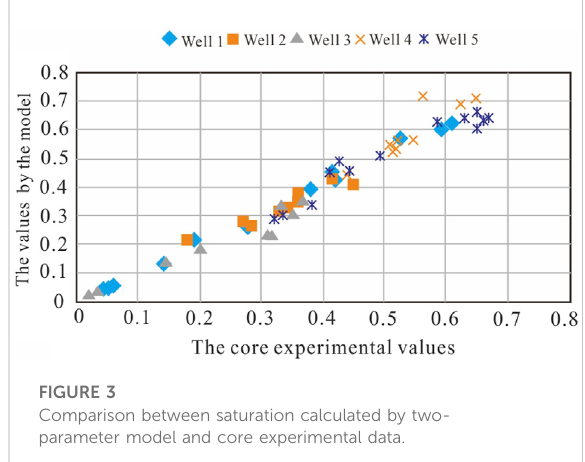
FIGURE 3 Comparison between saturation calculated by two- parameter model and core experimental data.